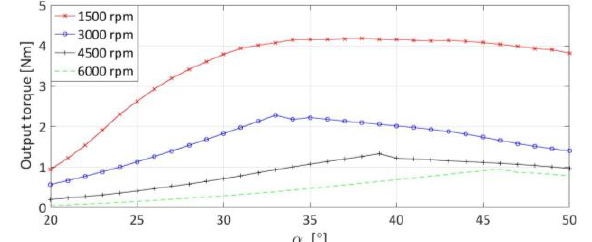
Fig. 3. Output torque vs. phase supply ranges at different rotational speeds in the serial configuration (S).